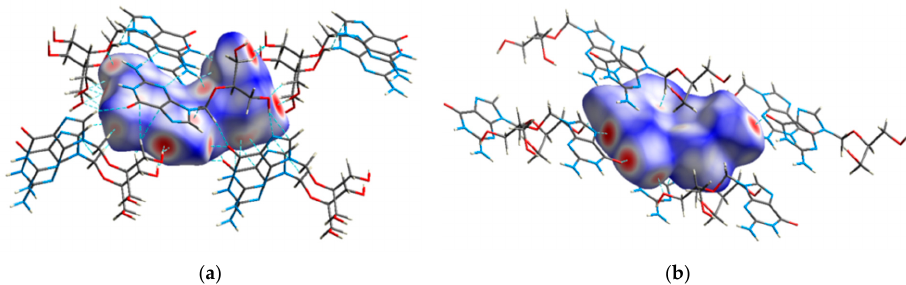
Figure 6. Hirshfeld surfaces with d norm as mapped function, constructed for ( a ) form I and ( b ) form II, with neighboring molecules to illustrate the network of non-bonding contacts, represented by dotted lines (not only hydrogen bonds).